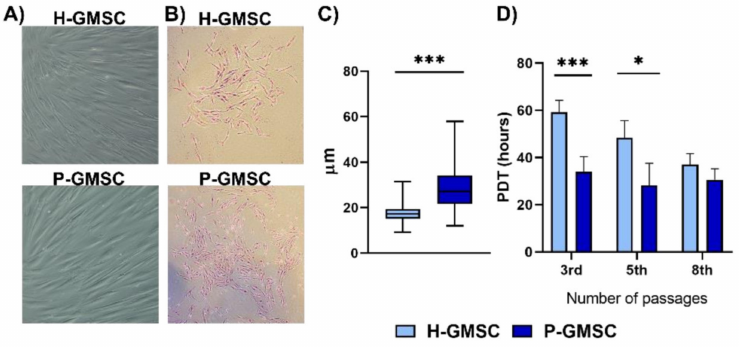
Figure 1. Morphology ( A ), CFU-F ( B ), cell-size ( C ) and population doubling time (PDT) ( D ) of H- and P-GMSC lines. ( A ) and ( B ) are representative images of one of each line, of the three, analysed. ( C ) represents mean ± SD of three lines (each measurement of 50 cells); *** p < 0.001. ( D ) represents mean PDT ± SD of three lines in each group; * p < 0.05; *** p <